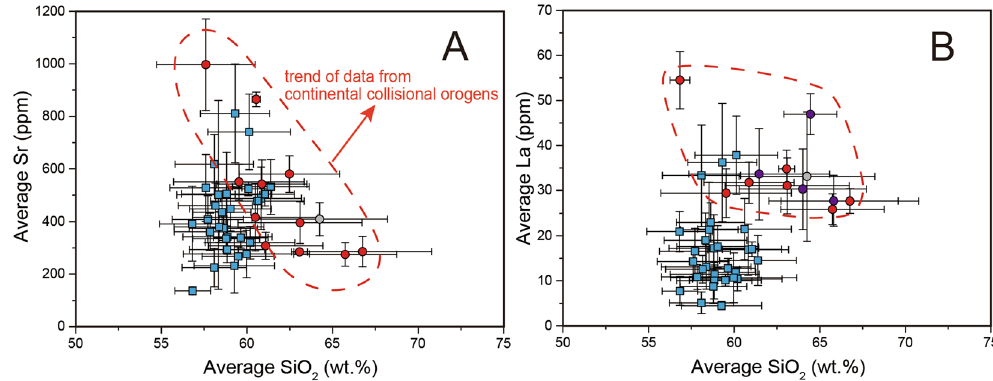
Figure 4. Relationship between whole-rock average Sr (ppm) ( A ), average La (ppm) ( B ) and average SiO 2 (wt.%) of data subsets in continental collisional belts (this study) and subduction-related arcs 5, 7 , reflecting lower Sr content in collisional belts being related to early plagioclase crystallization and uniformly high La content in collisional belts. The symbols are same to Fig. 3. The red dashed line represents trend of data from continental collisional orogens. The plotted data are listed in Supplementary Information.